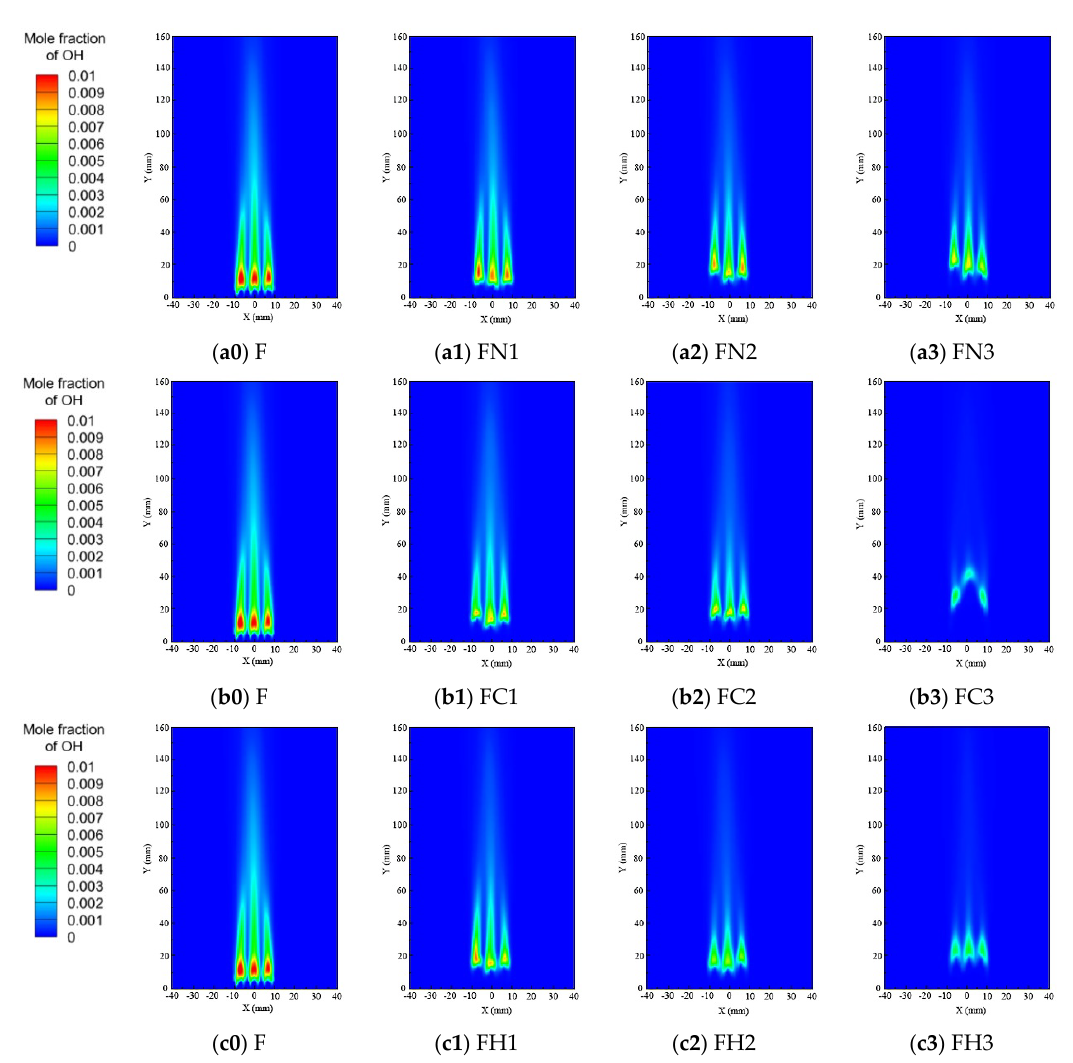
Figure 5. Variation in the HRR with the diluent fractions.